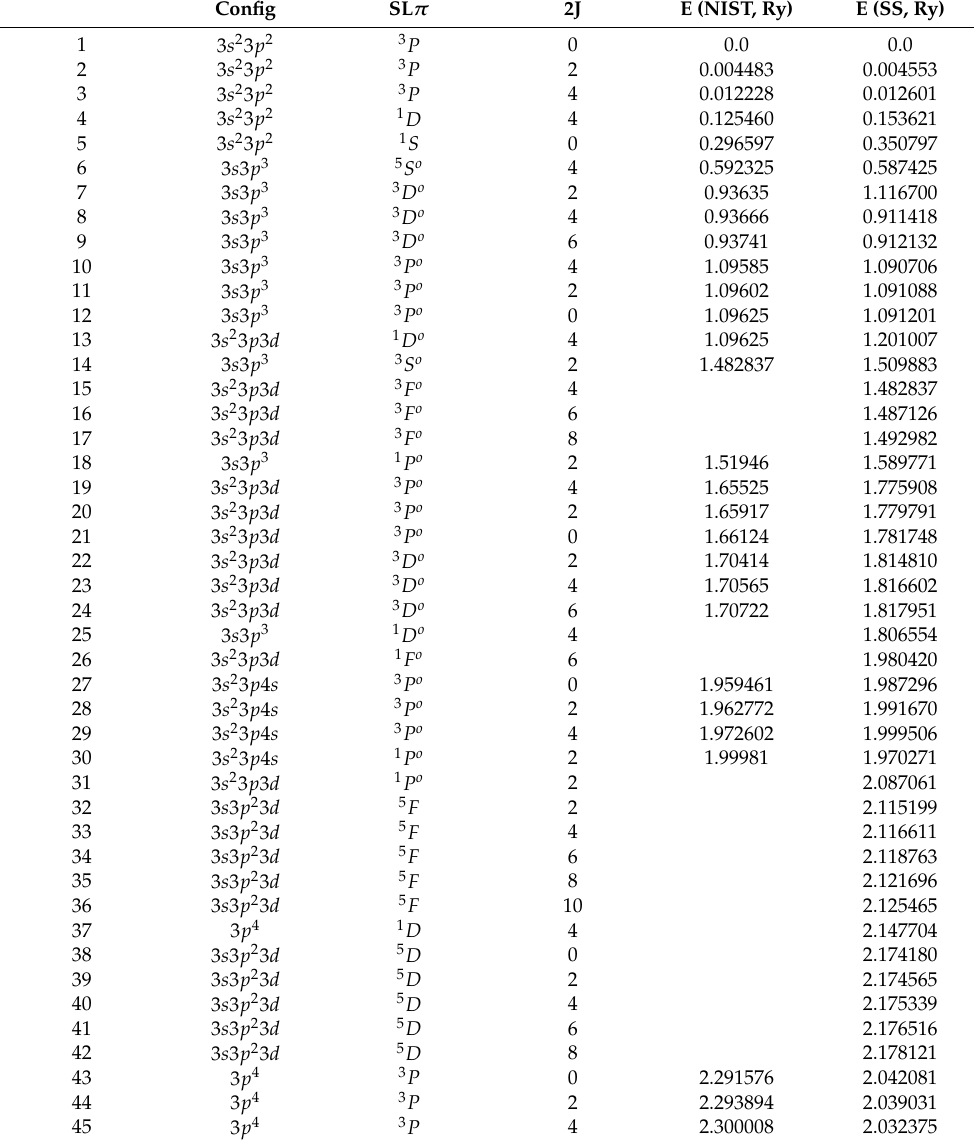
Table 1. The 45 levels of Cl IV that were included in the CC wavefunction expansion for Cl III. The calculated energies in Ry obtained from SUPERSTRUCTURE (SS) are compared with the measured values [25] available in the NIST [26] compilation